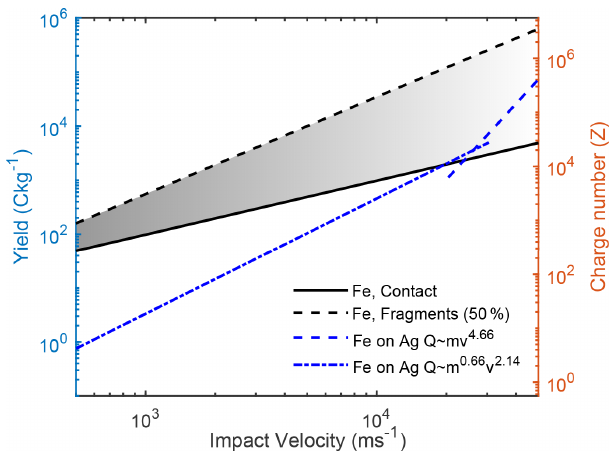
Figure 4. Simulation of contact charging of iron projectiles ( r p , 0 = 30nm) on a silver target with (black dashed line) and without (black solid line) a fragmentation model. The power laws plotted in blue were acquired experimentally by Mocker et al. (2013). In this cal- culation, the yield pressure of iron was set to Y = 50GPa, and the fragment size span was set to [ 0 . 2 , 3 ] nm. The label “50%” indicates that in this calculation, χ = 0 . 5; cf. Eq.